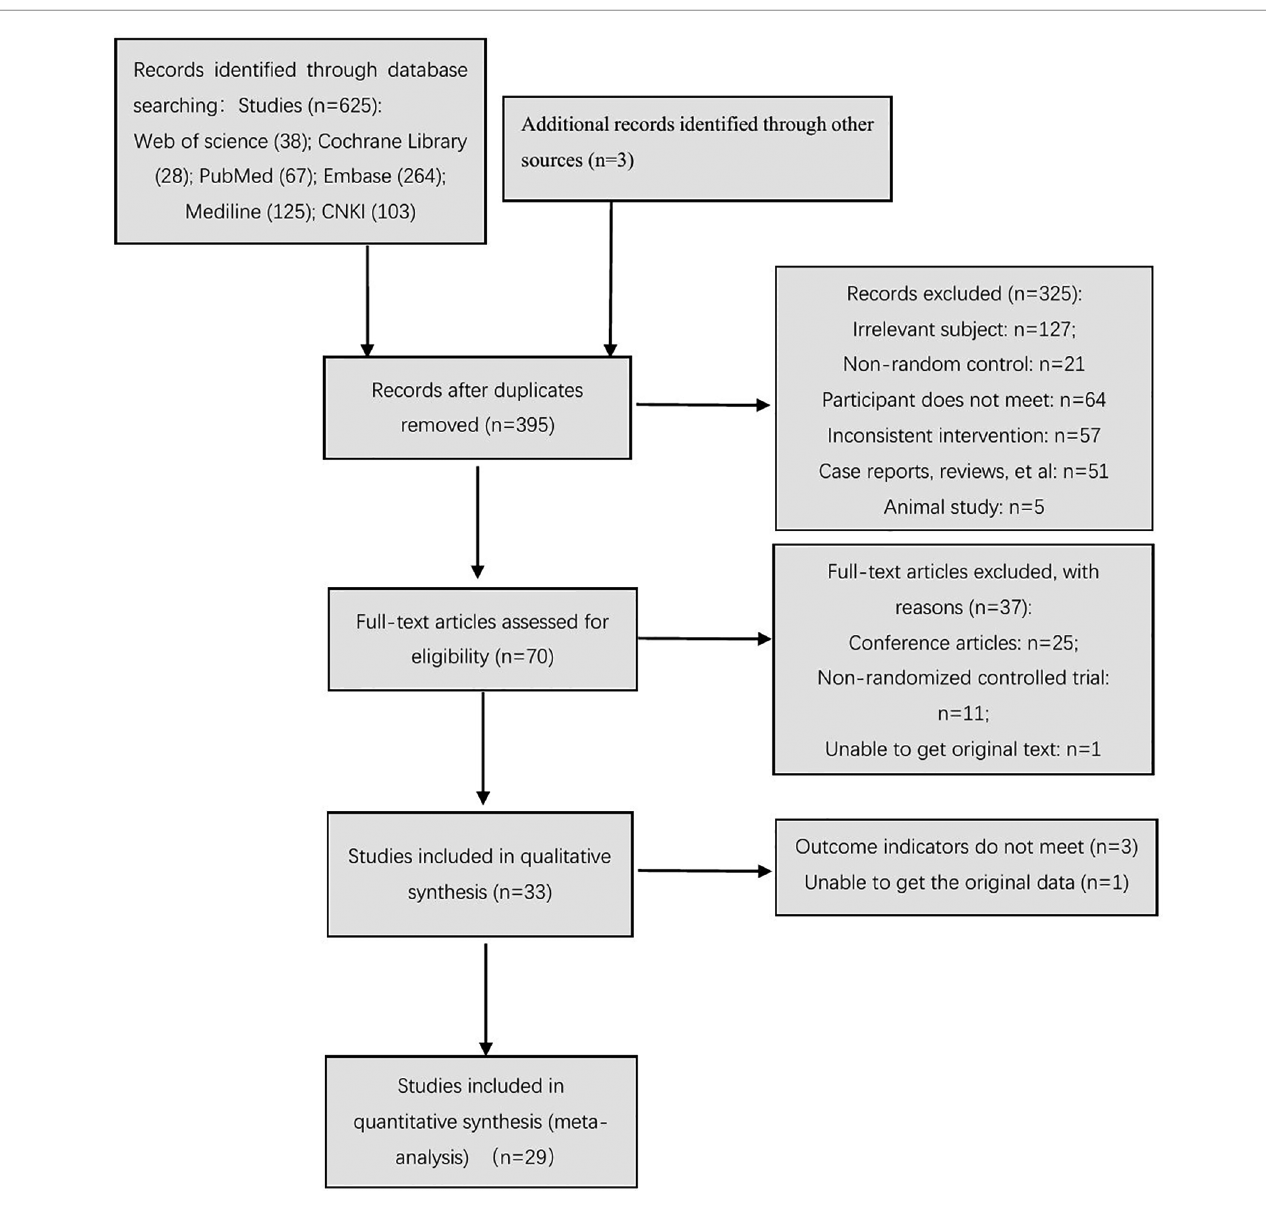
FIGURE 1 Flow chart of the search